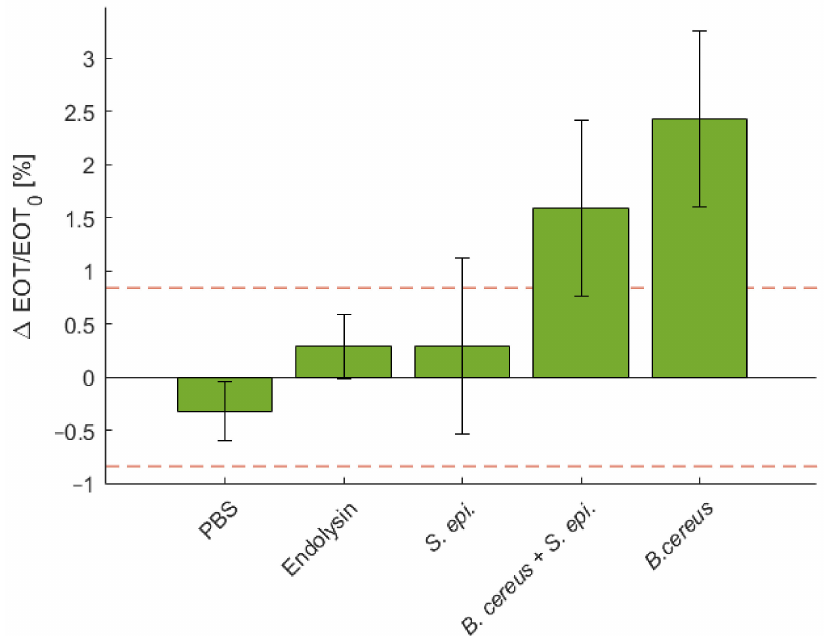
Figure 9. Characteristic relative EOT shift measured on a PSi membrane after 1 h in PBS, in a PlyB221 endolysin suspension, in a S. epidermidis suspension, in a mixture of B. cereus lysate and S. epidermidis and in B. cereus lysate only ( n ≥ 3). The dashed red line represents the noise level, fixed as 3 σ of the signal measured in PBS. Only the detection of mixture of B. cereus lysate and S. epidermidis induced a significant shift.